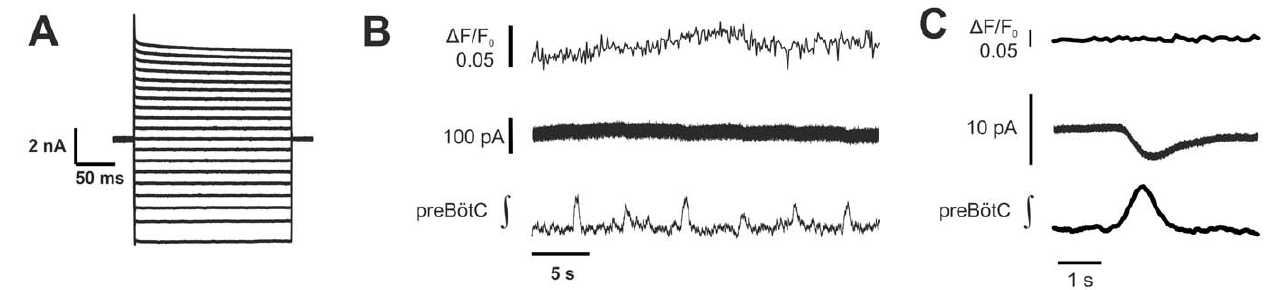
Figure 4. Astrocytes do not exhibit rhythmic calcium signals. ( A ) Current steps evoked in a EGFP-expressing astrocyte by depolarizing and hyperpolarizing voltage steps (10 mV increments) from a holding potential of 2 70 mV to potentials between 2 150 to + 30 mV. This type of current responses to voltage steps is typical for a passive astrocyte. Panel ( B ) shows calcium signals ( D F/F 0 ) and membrane current (pA) recorded from the particular astrocyte characterized in panel (A), along with simultaneously recorded field potentials (preBo¨tC 8 ). In this example, the fluorometric calcium signals ( B, Cc ) were obtained with Calcium orange (200 m M) loaded via the recording pipette. Rhythmic current fluctuations are buried in the noise but are unmasked by cycle triggered averaging in (C). No phase-locked astrocytic calcium signal could be detected.